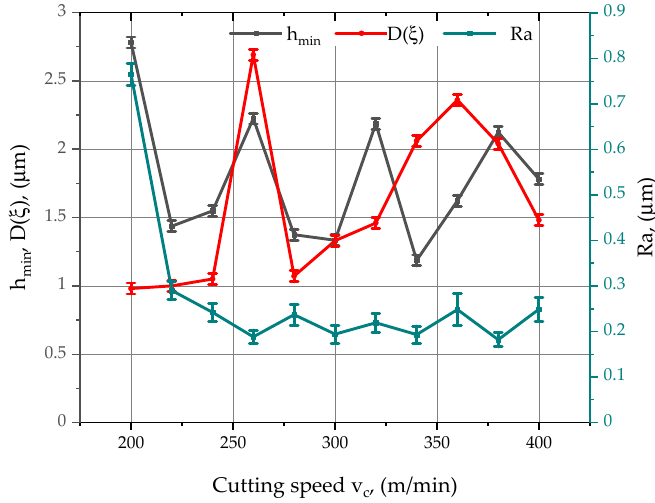
Figure 7. Effect of changing v c and selected machining conditions on the Ra parameter of the surface roughness of aluminium alloy 2017A.